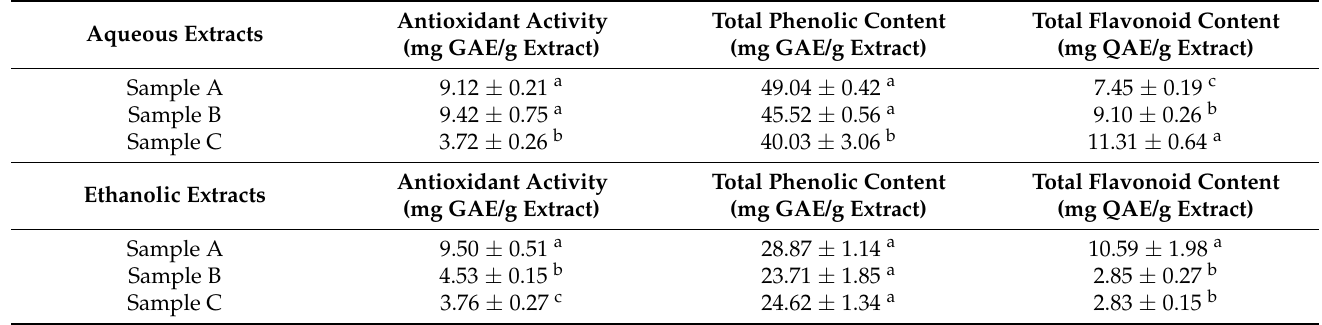
Table 4. Antioxidant activity, total phenolic and flavonoid contents of C. militaris